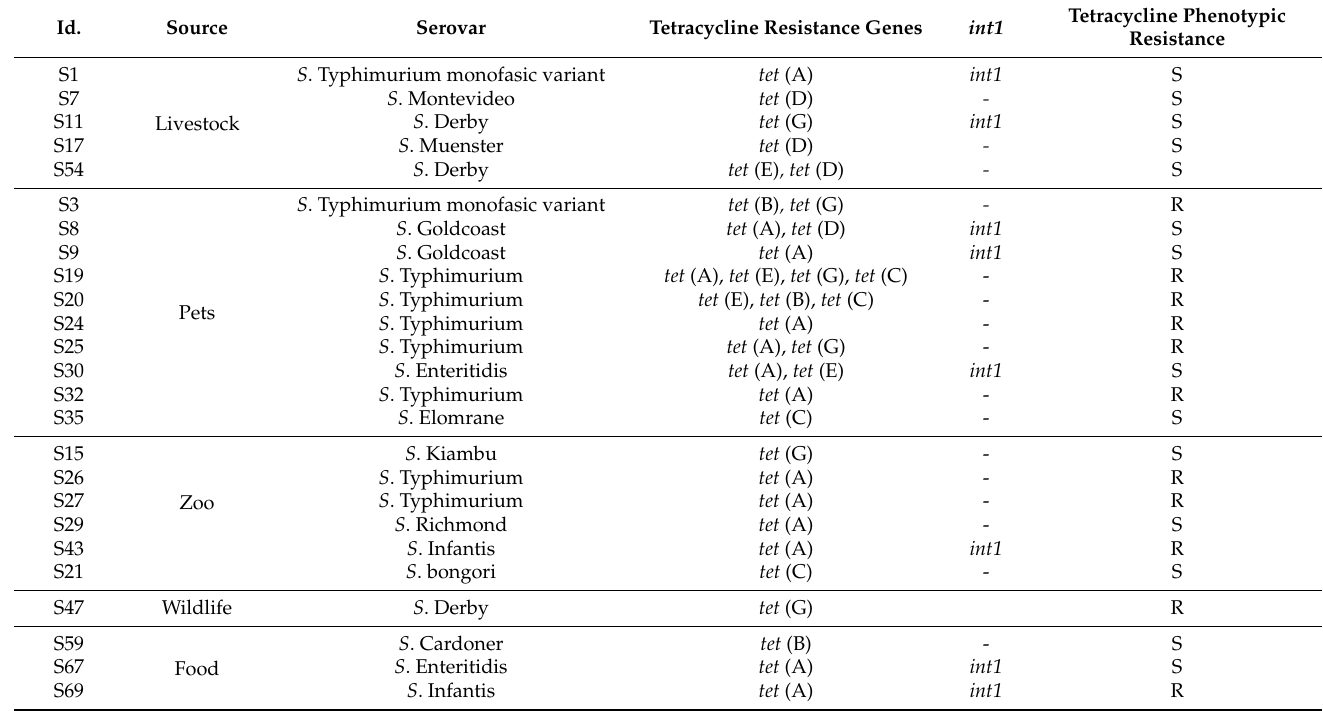
Figure 2. Number of resistant strains detected. The tet (G) was the second most represented gene, found alone or in association with other tet genes in 5/25 of the strains; while the tet (C) and tet (D) genes were found at the same frequency (4/25) among the analyzed strains; finally, tet (B) gene was found in 3/25 strains. The tet (E) gene was the least frequently detected, in fact it was harbored only by 2/25 strains. Concerning int1 gene, it was found in 17/60 strains, 8 of which harbored at least one tet gene. Moreover, among the 25 strains that possessed at least one tet gene, only 11 were phenotipically resistant to tetracycline (Table 3) and nine tetracycline resistant strains did not contain any of the analyzed genes. Table 3. Genotypic and phenotypic resistance to tetracycline